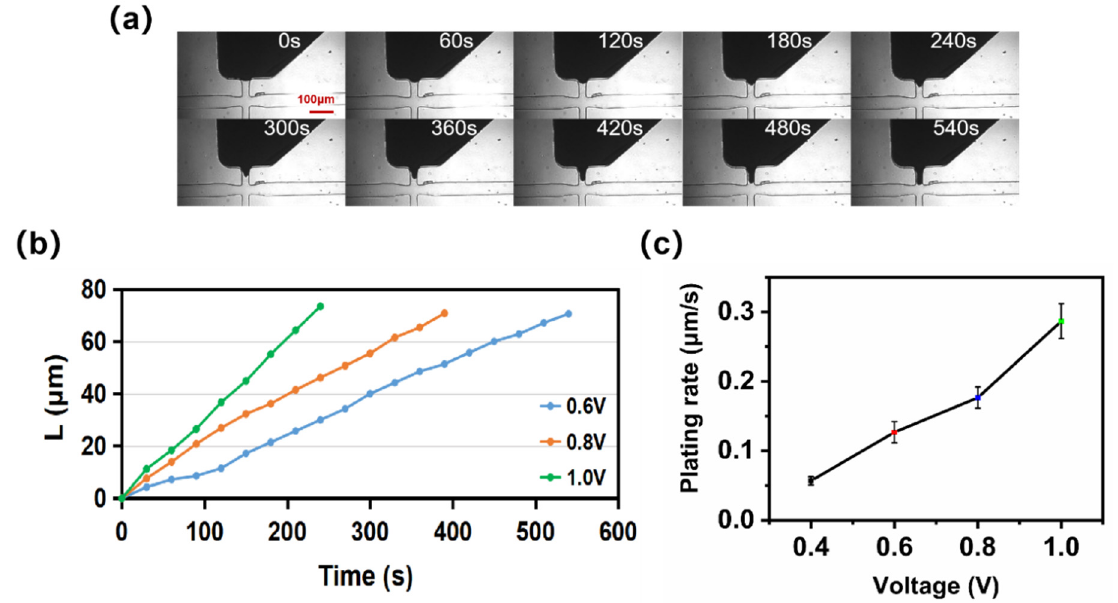
Figure 4. Effect of voltage on microplating: ( a ) Photograph of copper layer growth with time at 0.6 V. ( b ) The curve of copper layer thickness versus time at different voltages. ( c ) Average electroplating rate at different applied voltages.